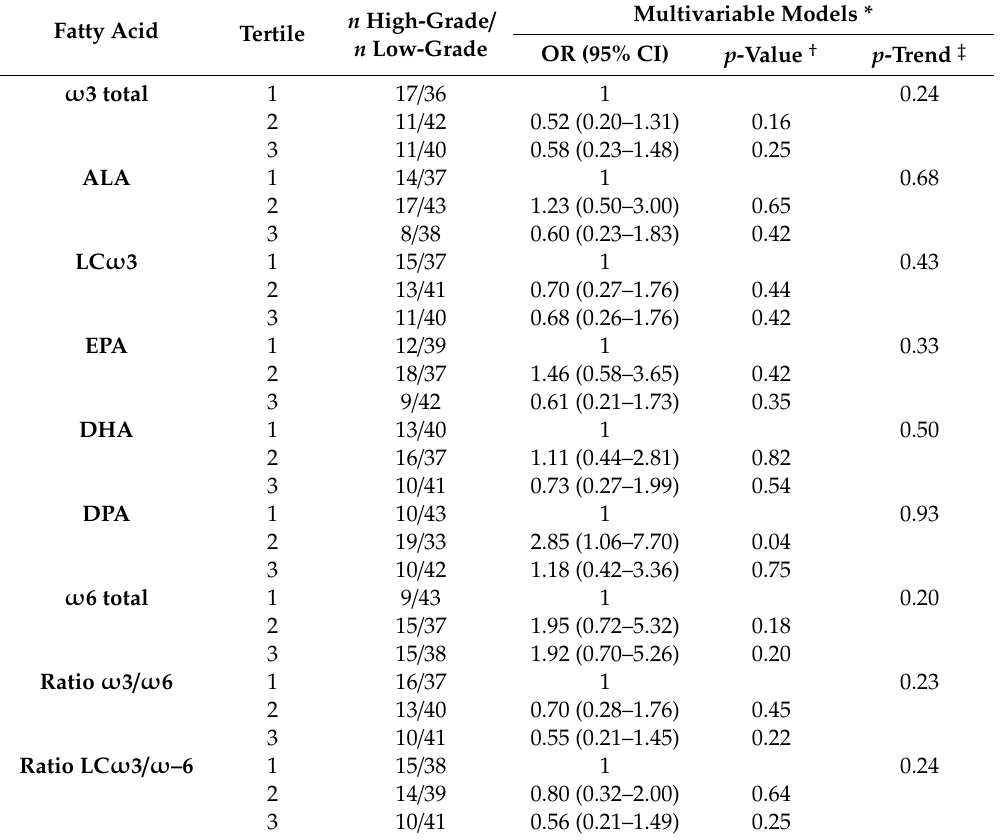
Table 6. Associations between fatty acid profiles of RBC and high-grade prostate